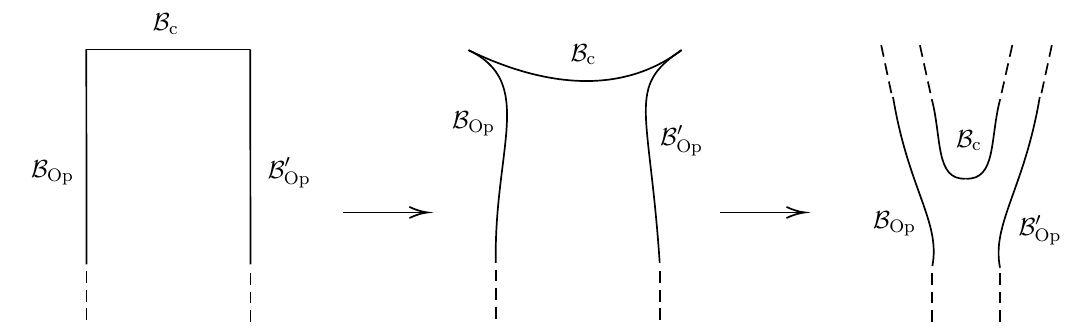
Figure 2 . Topological deformation of sigma model worldsheet I × R +